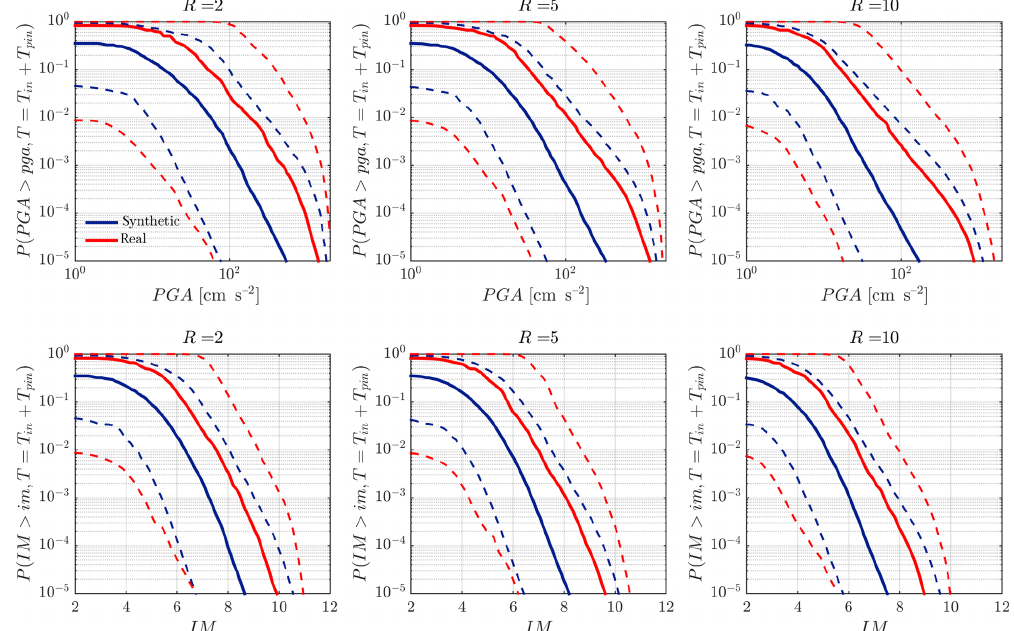
Figure 7. PSHA analysis comparison between source model SM1 (Table 1) and SM2 (synthetic catalog). Solid lines: medians. Dashed lines: 10% and 90% quantiles. Intensity measure: